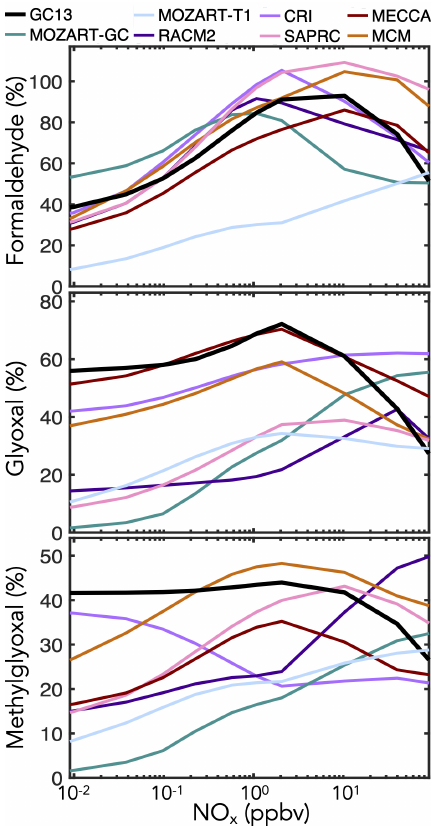
Figure 7. Simulated molar yields of formaldehyde, glyoxal, and methylglyoxal from BTX oxidation in a continental boundary layer as a function of midday NO x mixing ratio. The model setup is de- scribed in Sect. 4.1. Molar yields are averaged over the eighth sim- ulated